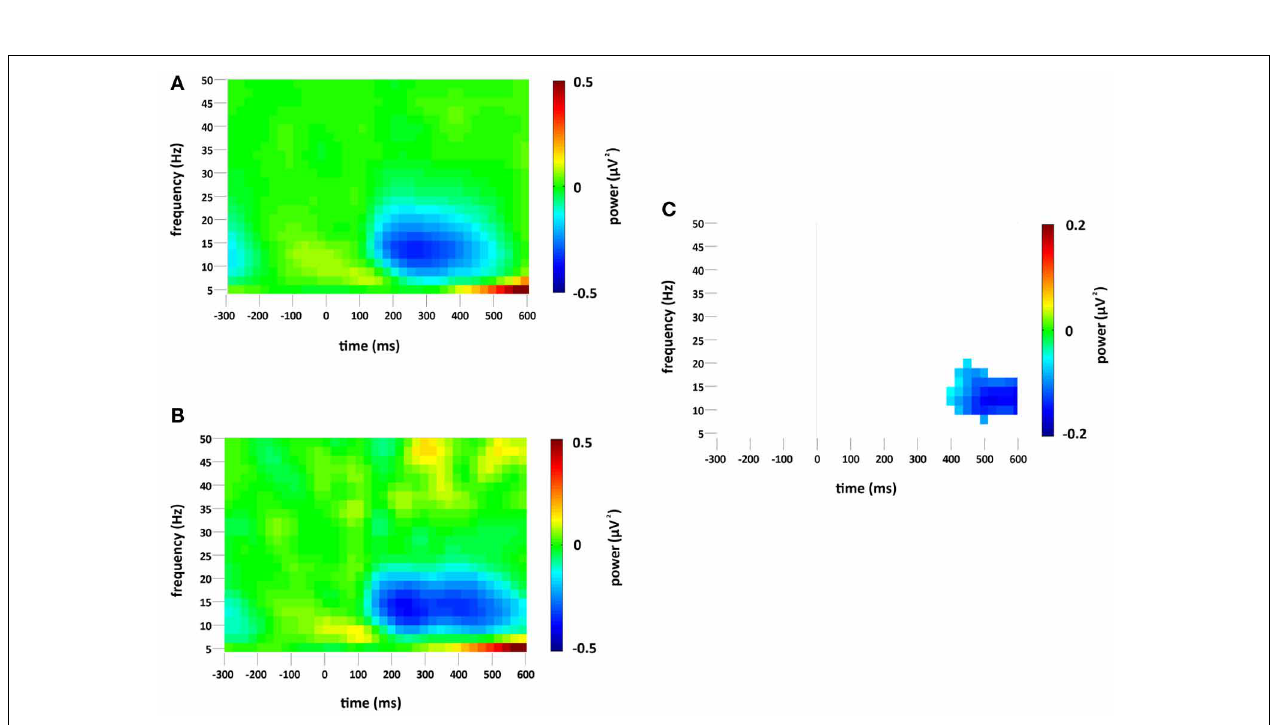
FIGURE 3 | Overall (i.e., stimulus phase-locked and non-phase-locked) spectral power change ( µ V 2 ) at the occipital region of interest compared to baseline ( − 300 to 0ms) for (A) standard and (B) deviant stimuli. Plot